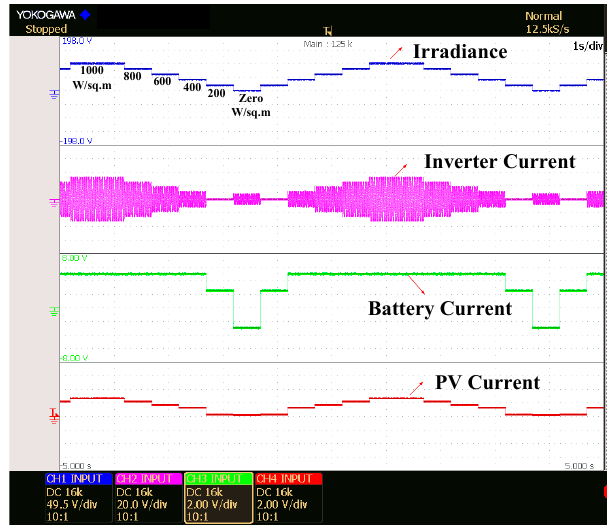
Figure 10. Inverter, battery and PV currents with varying irradiance value in grid-connected mode.